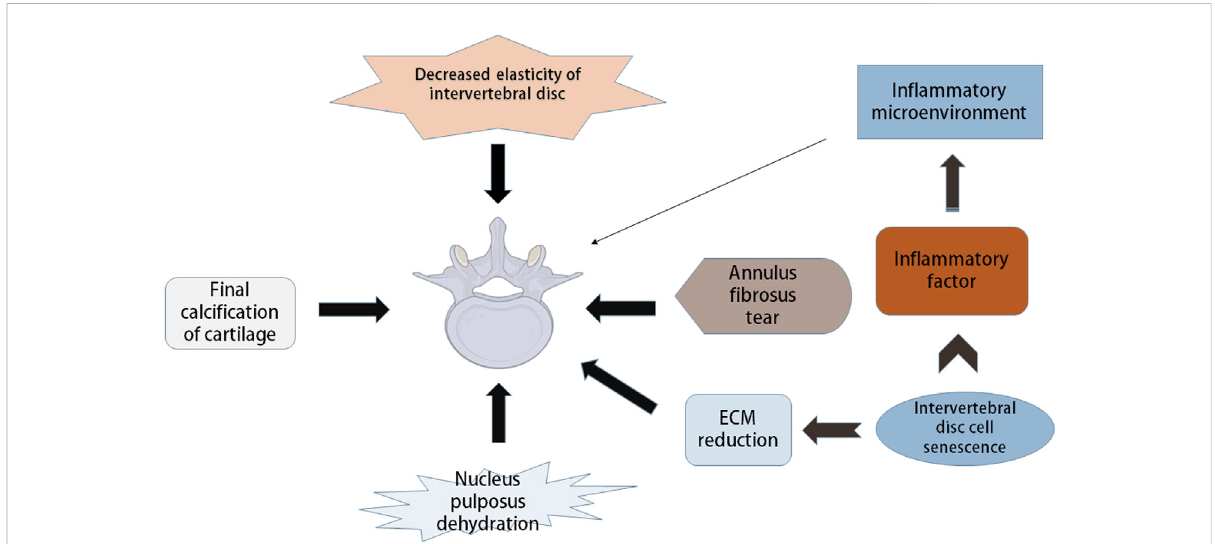
FIGURE 1 Pathological manifestation and mechanism of intervertebral disc degeneration. Intervertebral disc degeneration (IDD) includes many aspects, such as decreased disc elasticity, cartilage end-plate calci fi cation, reduced moisture in nucleus pulposus, annulus fi brosus tears, and changes in extracellularmatrix(ECM)components. IntervertebraldisccellsenescenceplaysamajorroleinIDD,whichcancausethereductionofECM,andcan secrete in fl ammatory factors leading to the in fl ammatory state of intervertebral disc microenvironment, thus causing IDD.